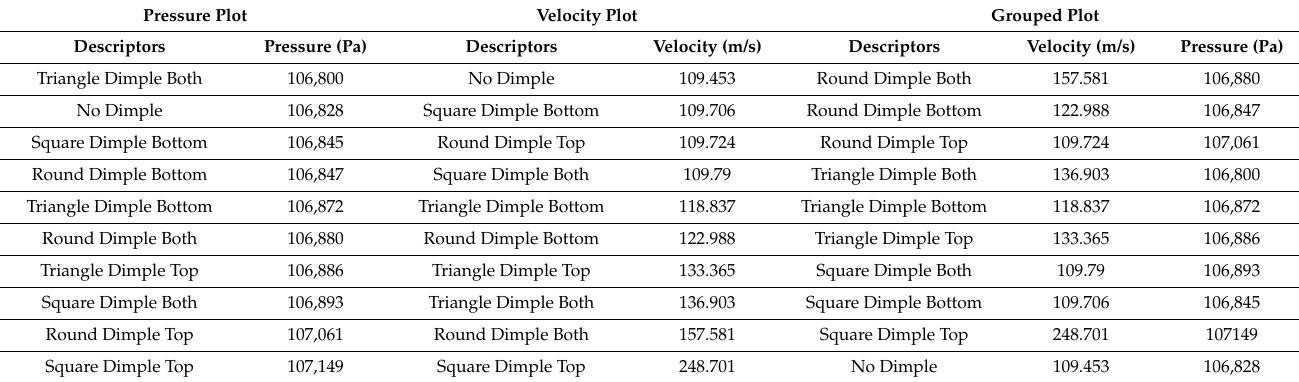
Table 9. The pressure and velocity distribution for the 10 dimple designs.